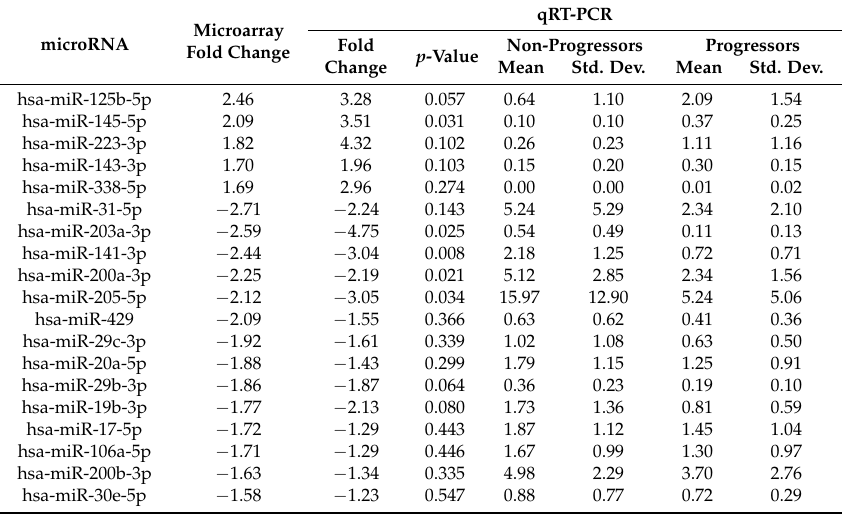
Discovery sample set: MicroRNAs (miRNAs) differentially expressed between the non-progressor and progressor groups. Negative fold change values indicate expression was higher in non-progressors. Microarray results of the fold change in expression are based on comparing pooled samples from each group. The qRT-PCR results (fold change, means, std. dev., and p -value) reflect an analysis of individual samples for each group (non-progresor group n = 10 and progressor group n = 7). Mean values are expressed as 2 − ∆ Ct . std. dev. = standard